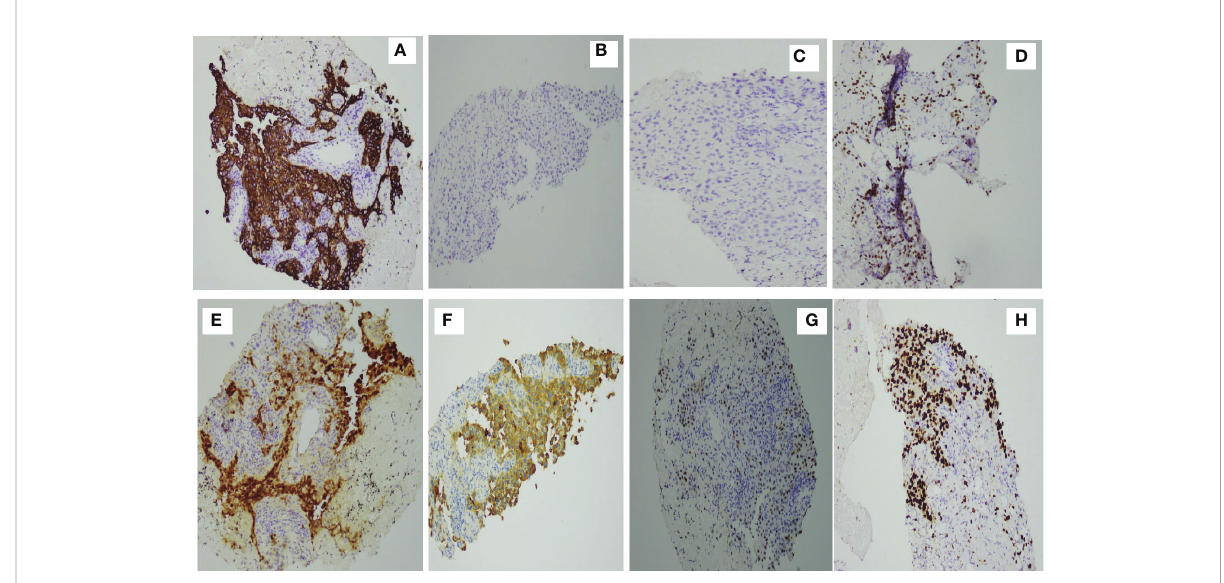
FIGURE 3 Immunohistochemical studies. Tumor cells are positive for (A) CK(+) (D) p63, (E) calretinin, (F) CK5/6, (G) WT-1, and (H) Ki-67 but negative for (C) p40 and (B)